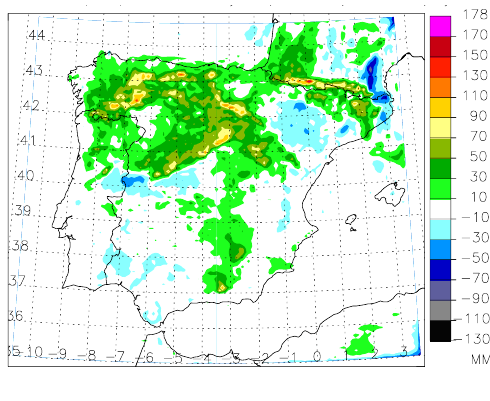
Fig. 6. Variation of the spatially accumulated daily precipitation difference, in kg, during the study period.